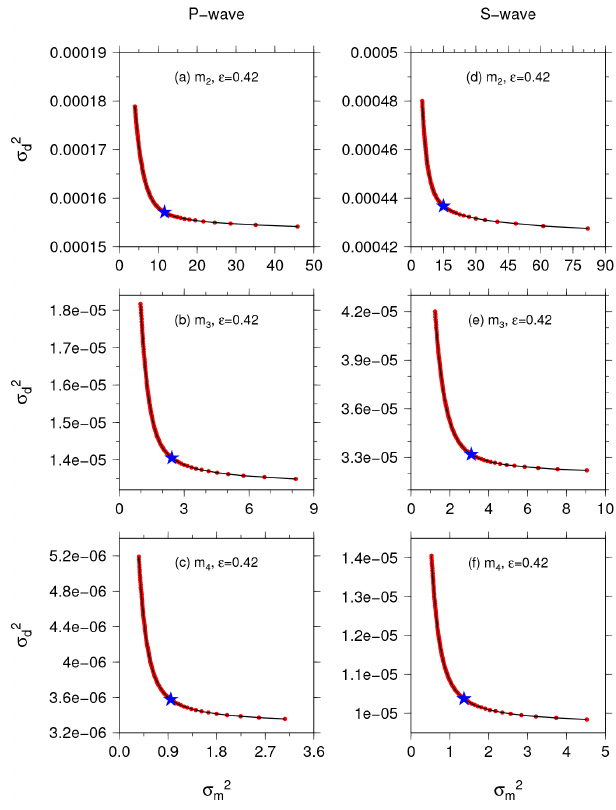
Figure 7. Trade-off analysis of data variance σ 2 and model variance d σ 2 m for damping parameters (cid:15) ranging from 0.1 (the rightmost red circle in each panel) to 2.0 (the leftmost red circle) with an interval of 0 . 02. Panels (a–c) show the trade-off curves of P wave checker- board resolution tests for models m 2 − m 4 from the 1st, 2nd and 3rd iteration. Panels (d–f) are for S wave checkerboard tests. The blue star in each panel represents the values of model variance and data variance for the optimal damping parameter (cid:15) (values indicated in the same panel) for P wave or S wave at each iteration. The value of the unitless model variance σ 2 m is at the scale of 10 − 4